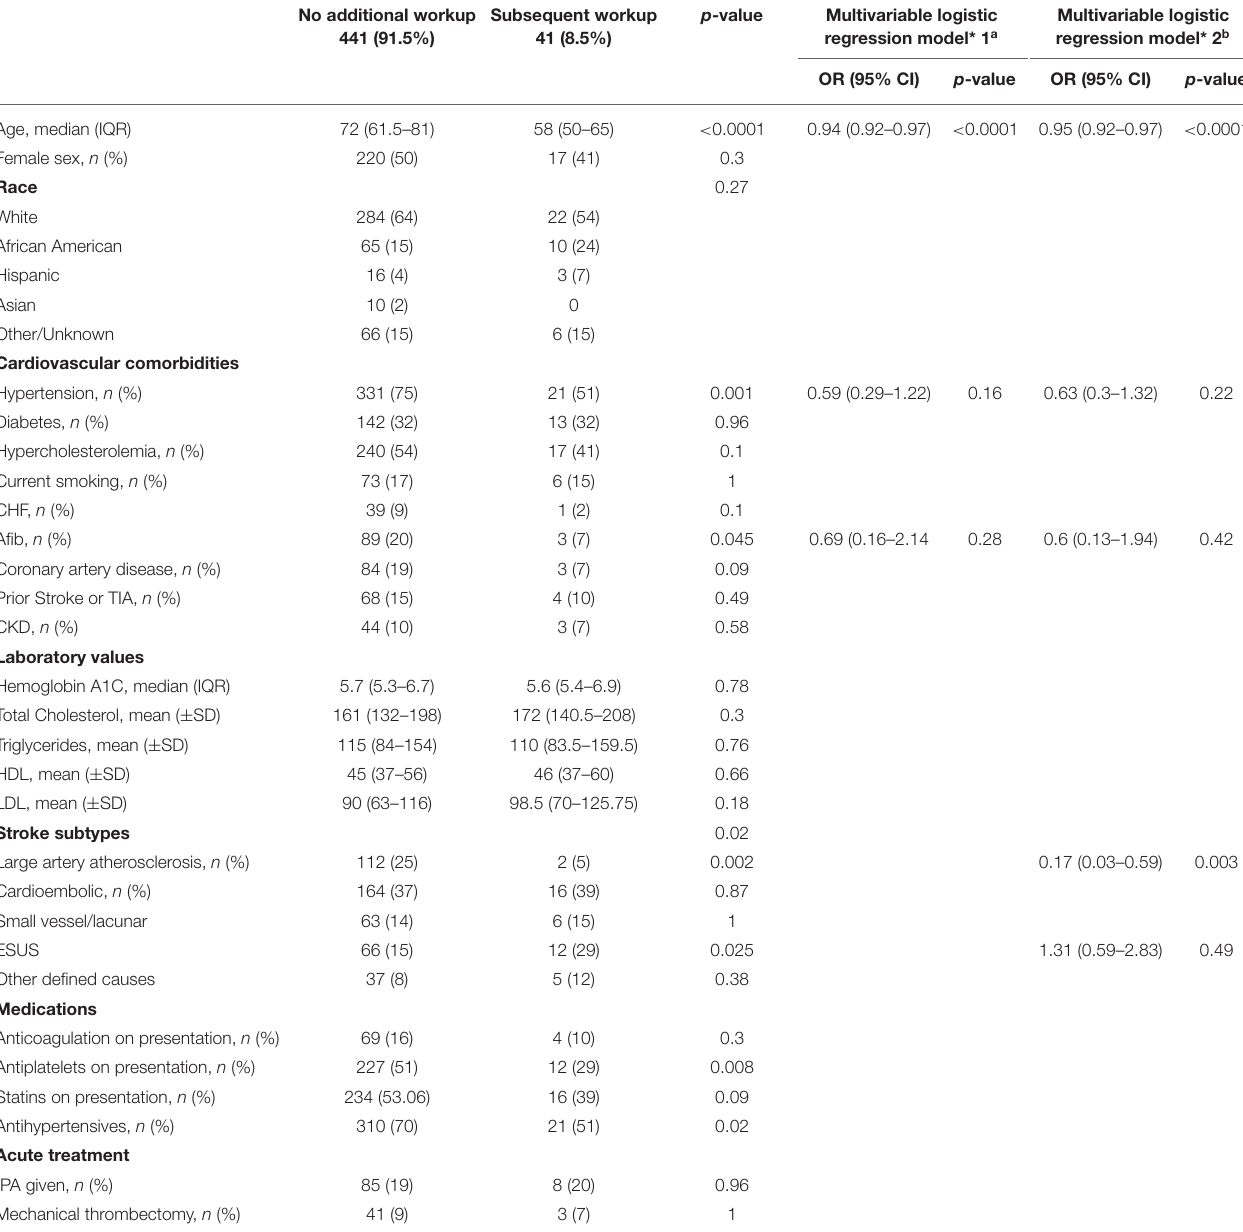
TABLE 3 | Comparisons between patients according to the need of subsequent work